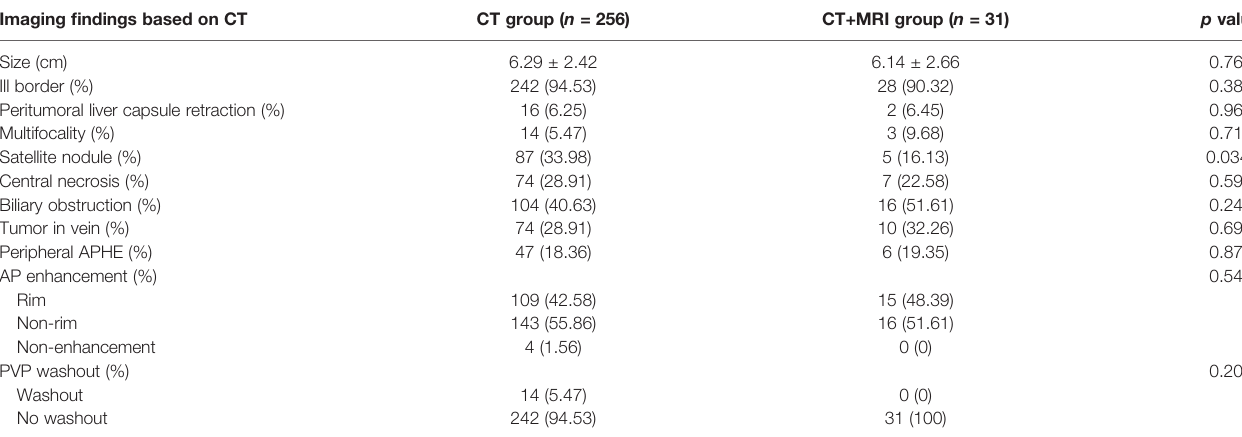
TABLE 2 | Imaging fi ndings based on CT of the ICC patients. Imaging fi ndings based on CT CT group ( n = 256)